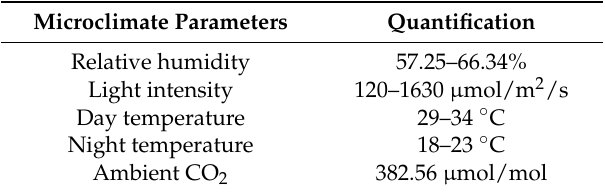
Table 6. Microclimatic condition under the research area during